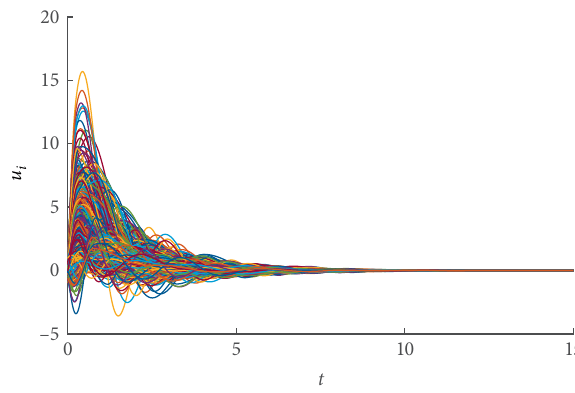
Figure 9: The control inputs 𝑢